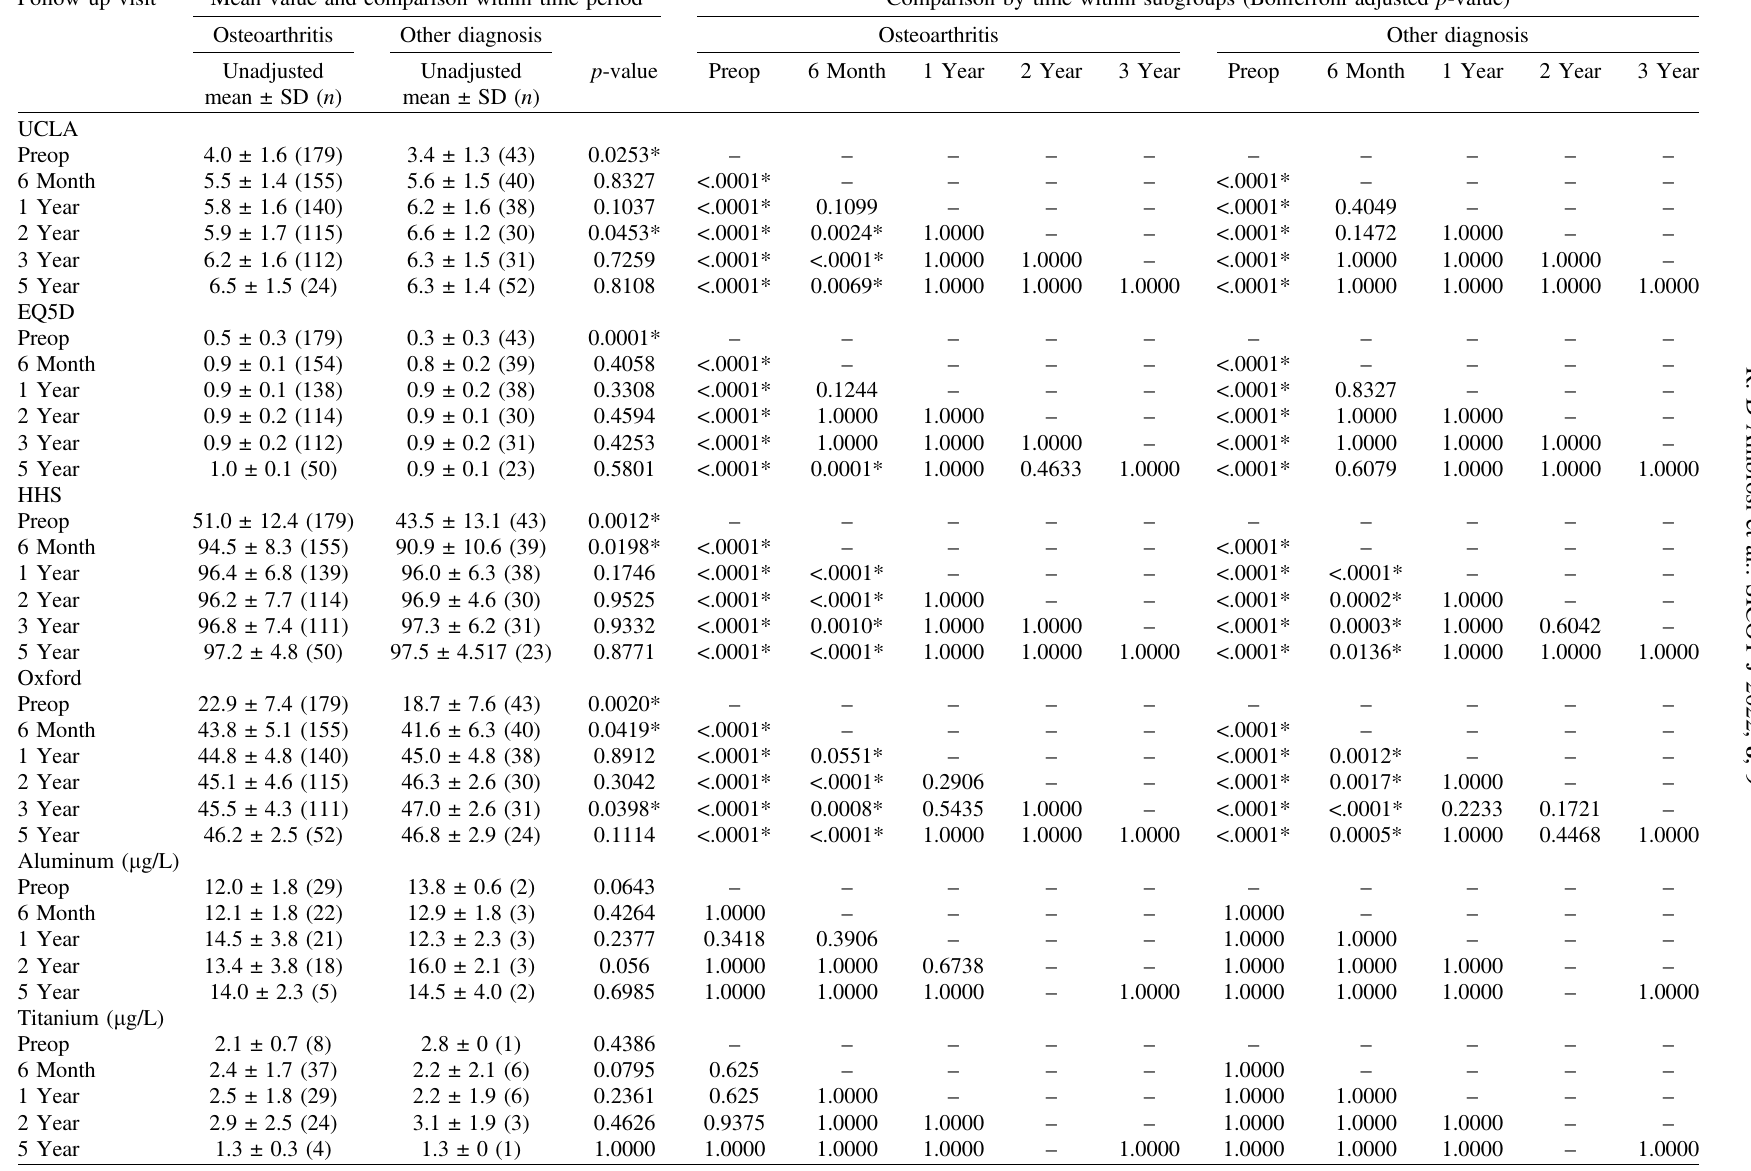
Table A.7. Subgroup analysis by primary